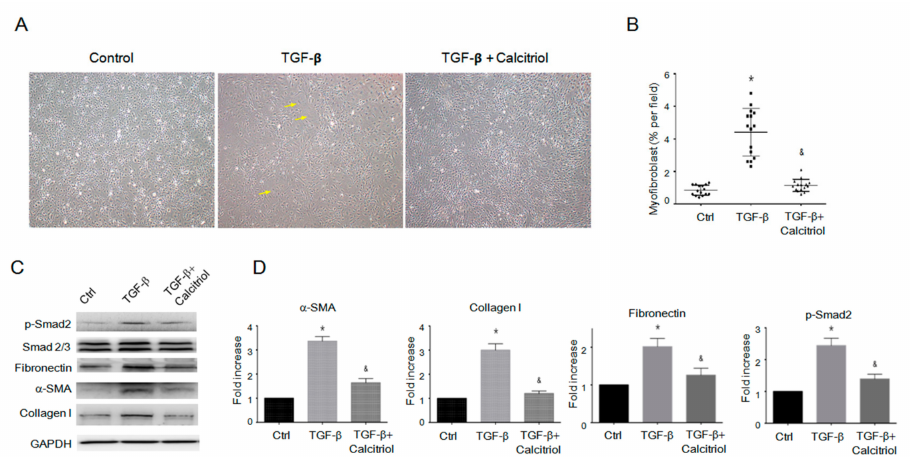
Figure 7. Calcitriol-attenuated TGF- β -induced fibroblast-to-myofibroblast transition (FMT) in vitro. ( A ) Representative photomicrographs of the myofibroblast. ( B ) Quantification of myofibroblast cells per visual field in the Ctrl, TGF- β only, and TGF- β –calcitriol groups. Experiments were conducted in triplicate (5 high power fields (HPFs) per mouse, 15 HPFs total). * p < 0.05 vs. Ctrl, & p < 0.05 vs. TGF- β . ( C ) Representative immunoblotting analyses of fibronectin, alpha-SMA, collagen I, and p-Smad2 in the cardiac fibroblasts. ( D ) Quantification of the relative protein levels (n = 3). GAPDH was used as an internal control. Total Smad2 was used as an internal control for p-Smad2. Data are expressed as mean ± SEM, and n represents the number of animals. * p < 0.05 vs. Ctrl, & p < 0.05 vs. TGF- β . Experiments were conducted in